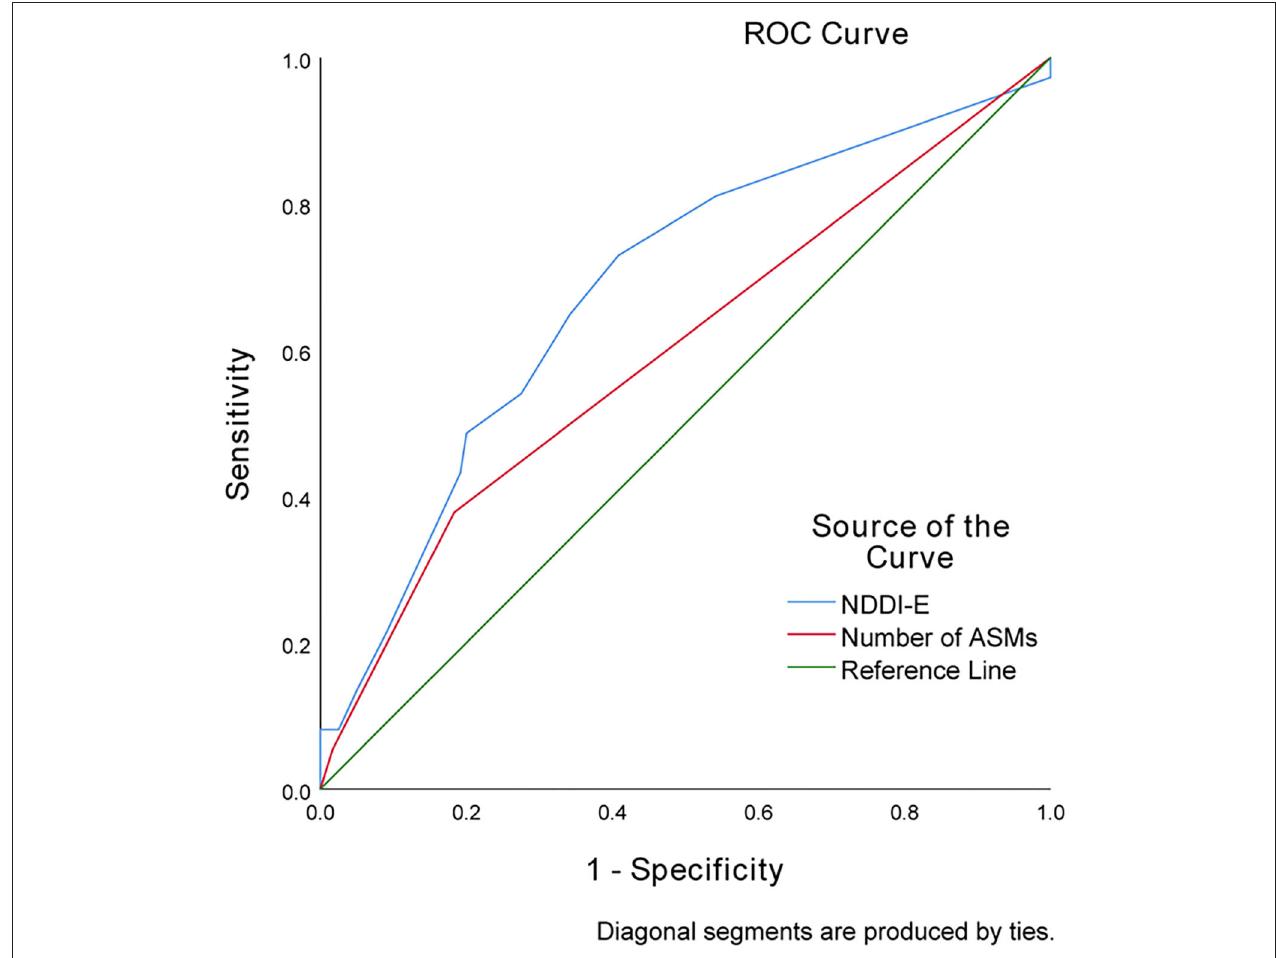
FIGURE 1 | Receiver operator characteristic curve demonstrating sensitivity as a function of 1-specificity for predicting anxiety symptoms based on the NDDI-E scores and number of ASMs in